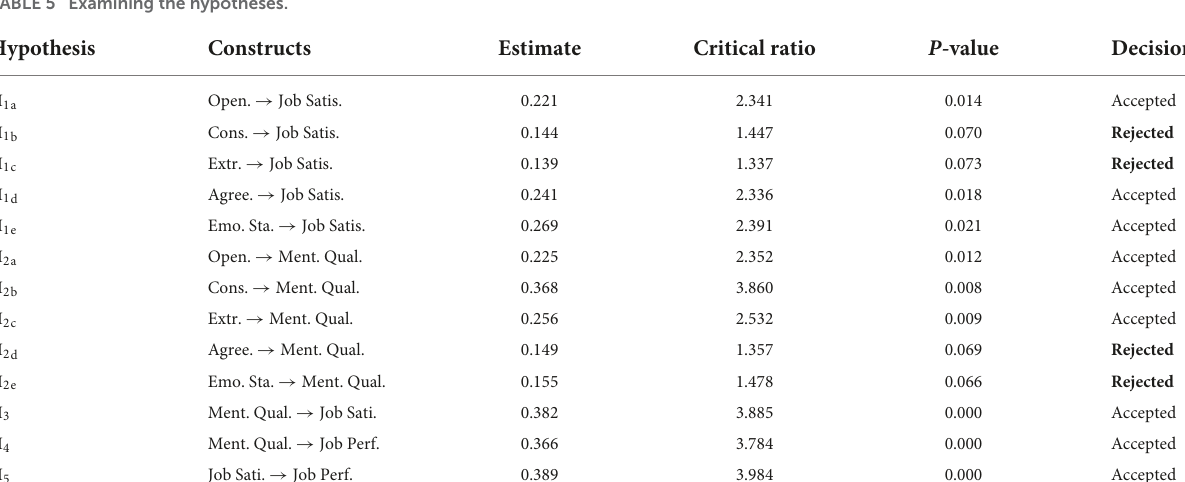
TABLE 5 Examining the hypotheses. Hypothesis